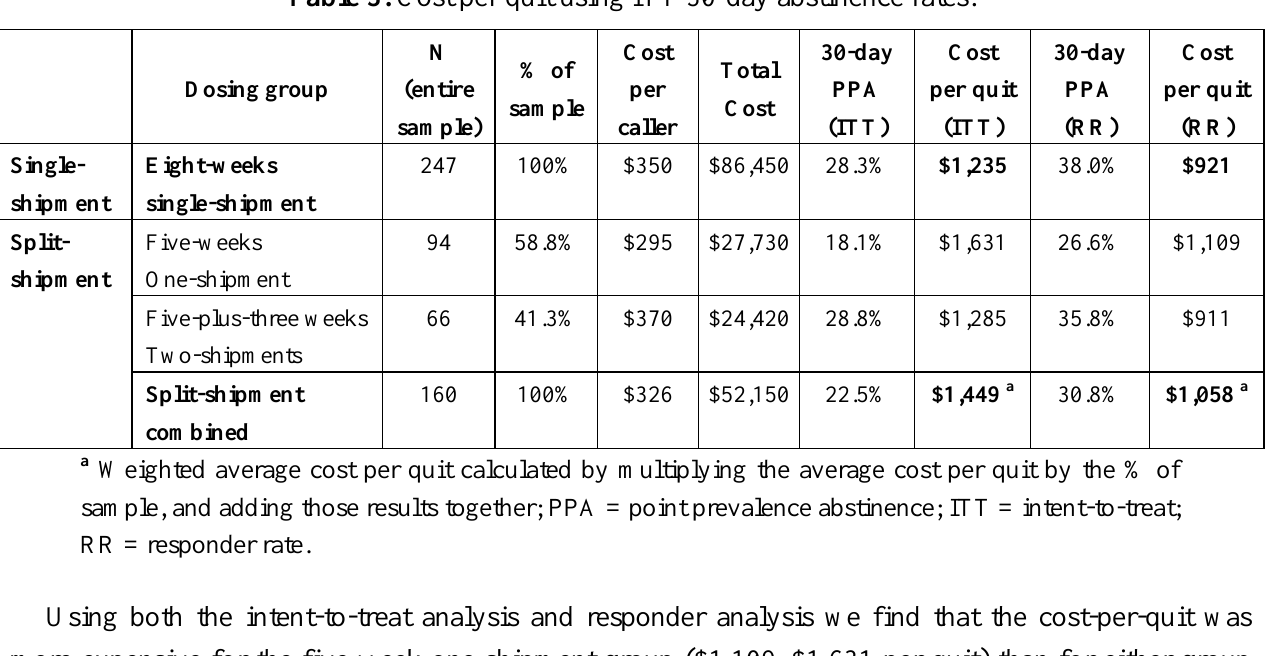
Table 3. Cost per quit using ITT 30-day abstinence